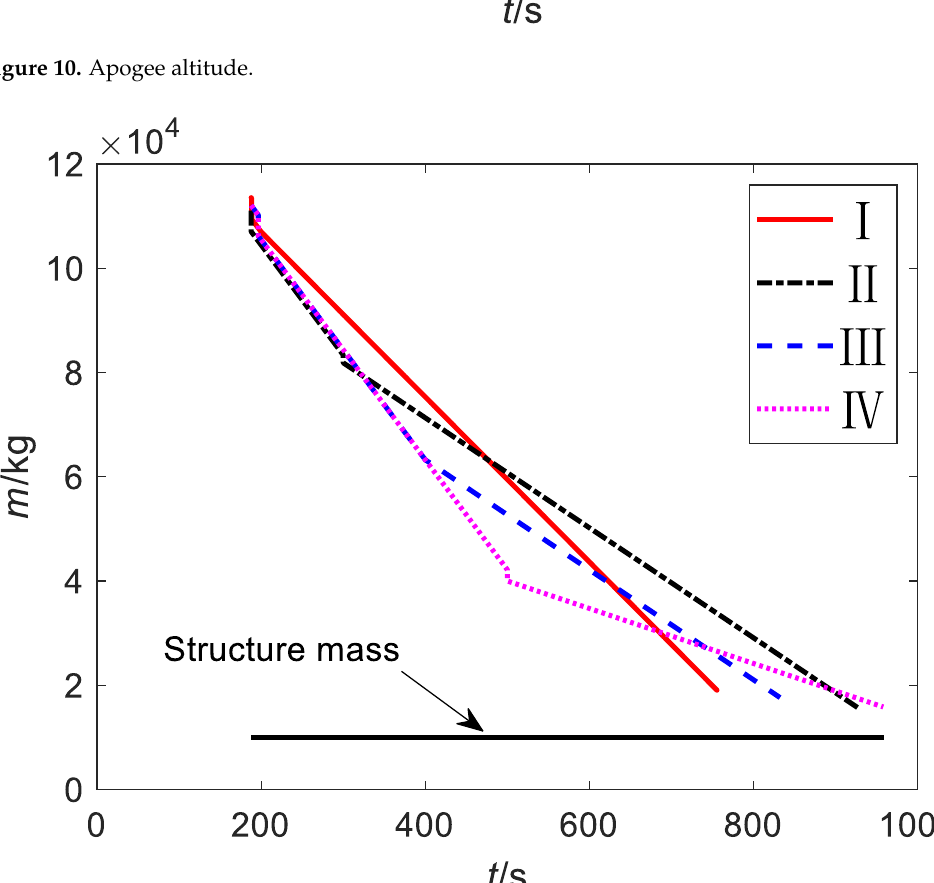
Figure 11. Mass. Figure 11.